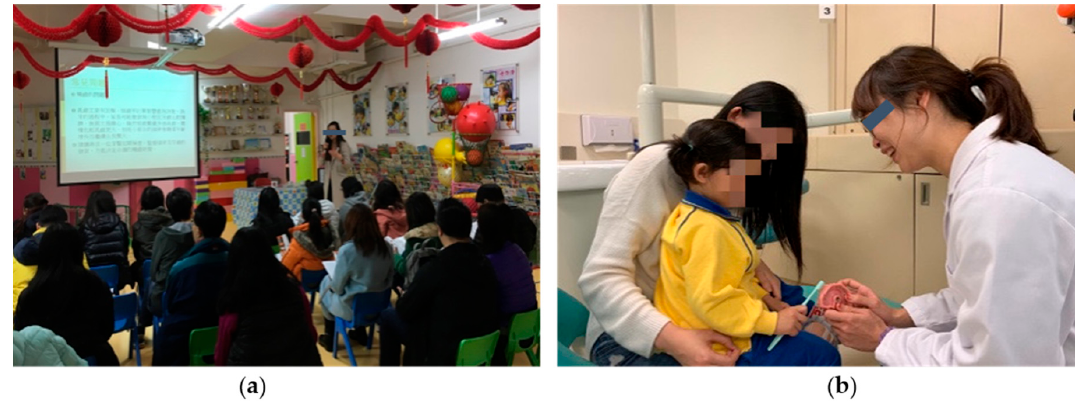
Figure 6. Oral health promotion to parents. ( a ) Oral health education talk for parents; ( b ) individual parental counselling and oral health education.